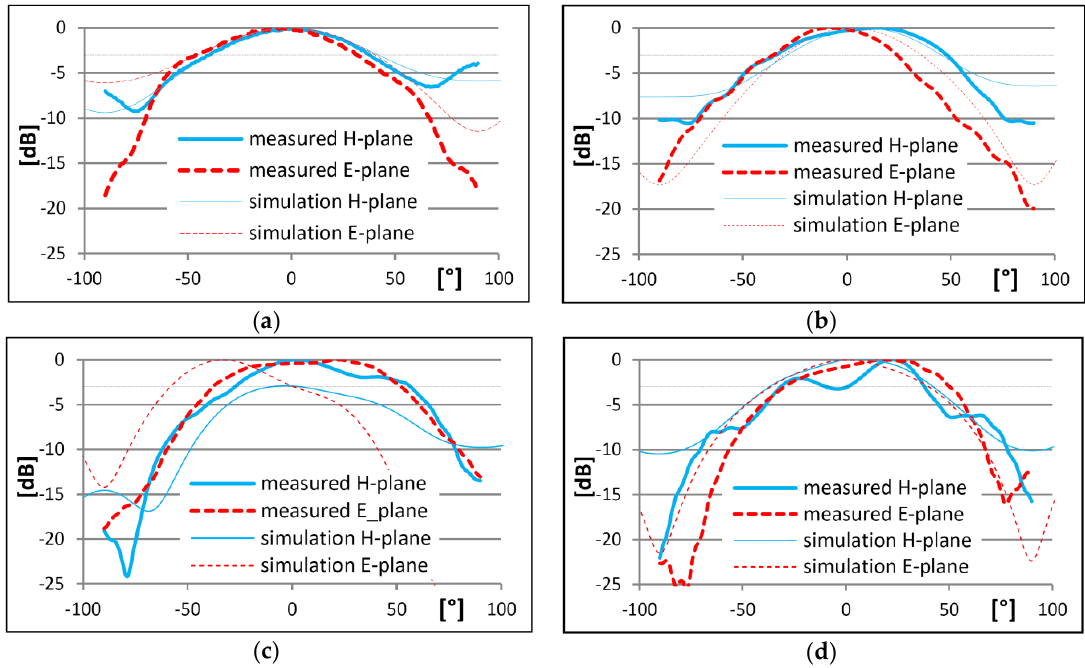
Figure 7. The antenna radiation patterns with a CPW excitation at frequencies: ( a ) 1 GHz, ( b ) 2 GHz, ( c ) 3 GHz, and ( d ) 4 GHz.